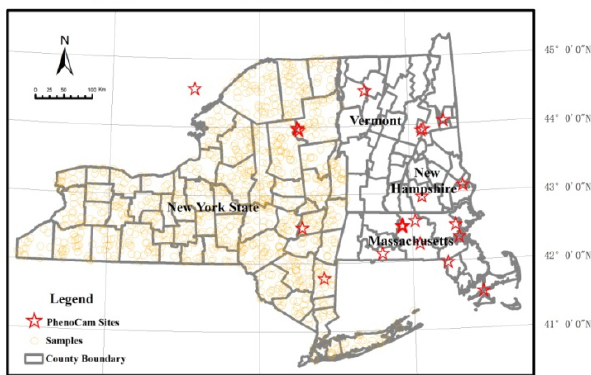
Figure 1. Geographical location of sample sites and PhenoCam sites in northeastern united states